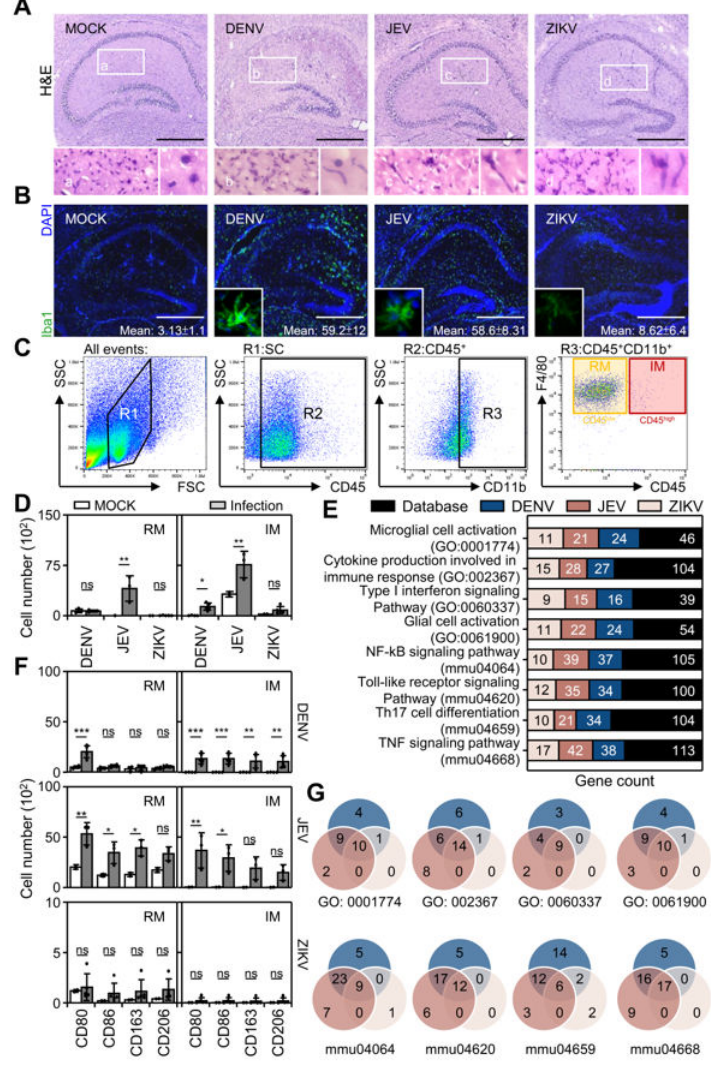
Figure 3. Flavivirus infection resulted in peripheral immune cell infiltration and inflammatory activation in the brain. In DENV-, JEV-, and ZIKV-infected hippocampi, hematoxylin & eosin staining (H&E) showed cell infiltration ( A ). ( B ) Immunofluorescent staining of Iba1 (green) indicated macrophage expression. DAPI (blue) was stained for nuclei. ( C ) The gating strategy in specific regions (R1-3) used to identify resident macrophages or microglia (RM, CD45 low CD11b + ) and infiltrated macrophages (IM, CD45 high CD11b + ). ( D ) The quantitative number of RMs and IMs in DENV-, JEV-, and ZIKV-infected brains ( n = 3). ( E ) Immunoprofile of macrophage polarization toward type 1 (CD80 and CD86) or type 2 (CD163 and CD206) in the RM and IM of infected mice ( n = 3). * p < 0.05, ** p < 0.01, and *** p < 0.001; ns, not significant. ( F ) Gene ontology enrichment analysis showed the changed gene count involving the inflammatory activation pathway. ( G ) Venn diagrams showed the commonality of inflammatory gene expression in three flavivirus infections. Scale bar = 400 µ